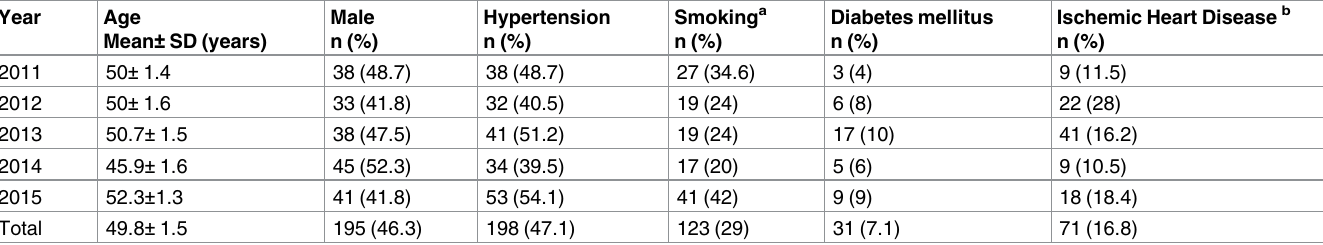
Table 2. Characteristics, risk factors and comorbidities of aSAH